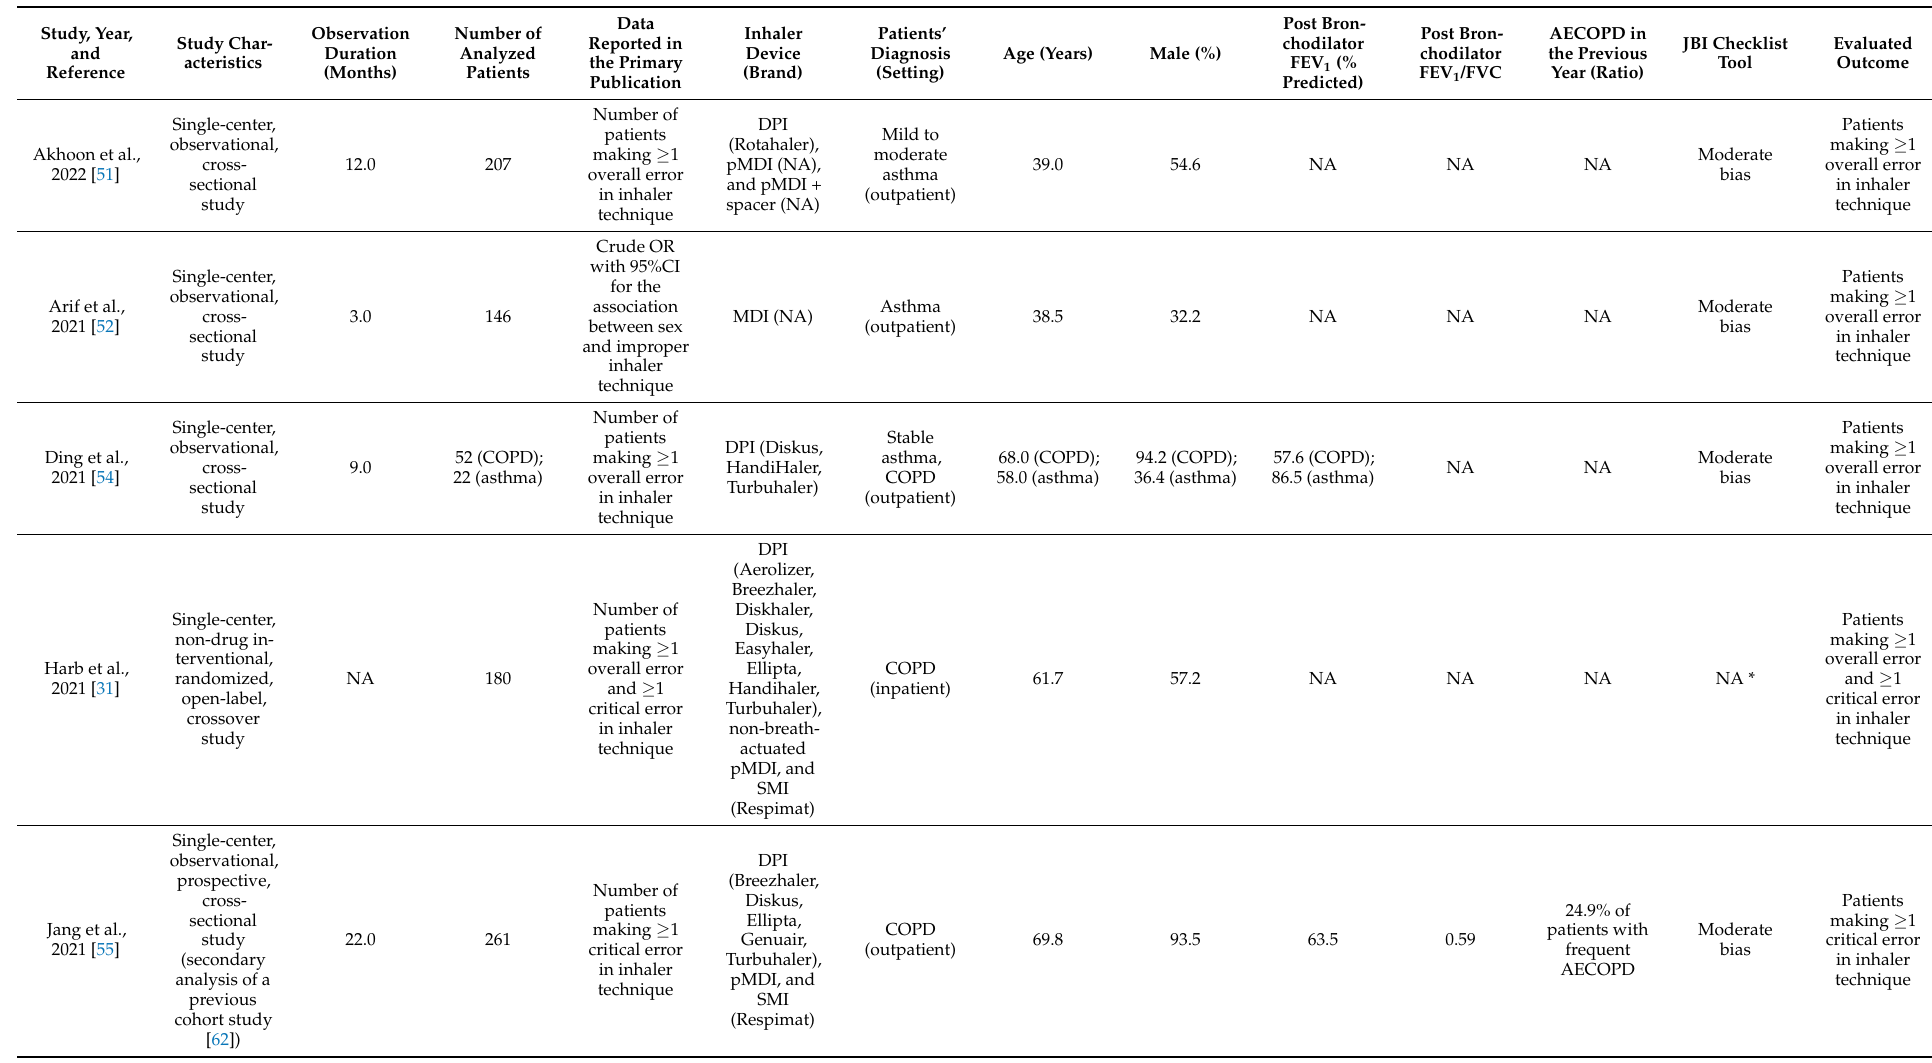
Table 1. Study characteristics of the clinical studies included in qualitative and quantitative